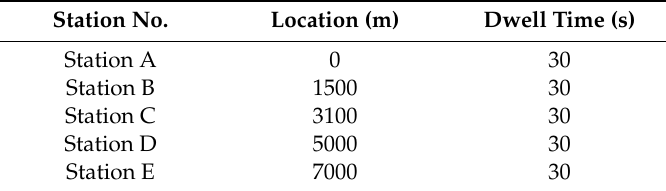
Table A2. Stations input parameters.